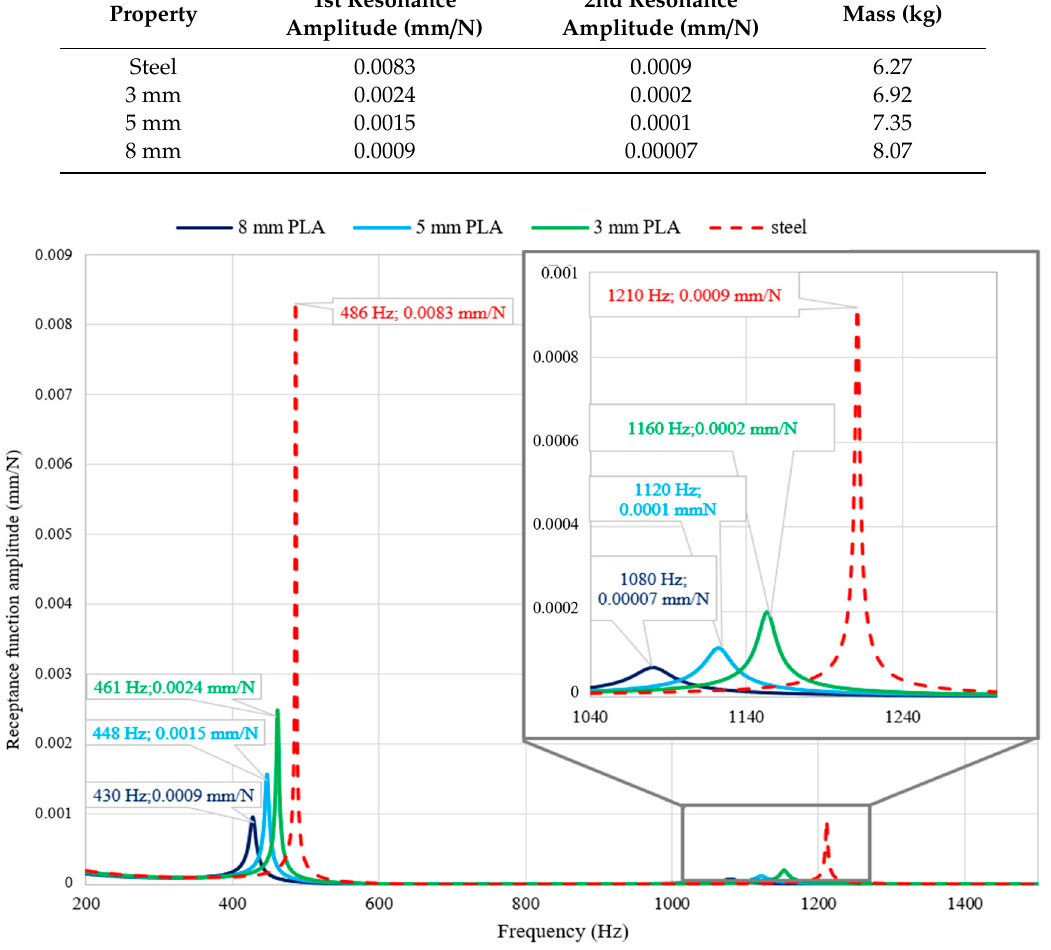
Figure 6. Comparison of the receptance functions for steel beam with the applied polylactide (PLA) cover of different thicknesses. Table 4. Free-free beams receptance function amplitudes for the first two resonances.